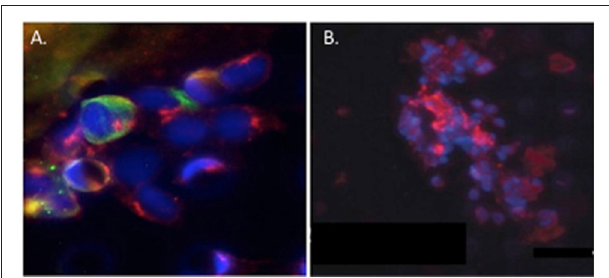
FIGURE 4 | Circulating cCAF/circulating tumor cell (CTC) clusters and cCAF clusters in breast cancer patient blood. (A) cCAF/CTC co-cluster and (B) cCAF cluster. Red: FAP, Green: CK. From Ao et al. (2015).